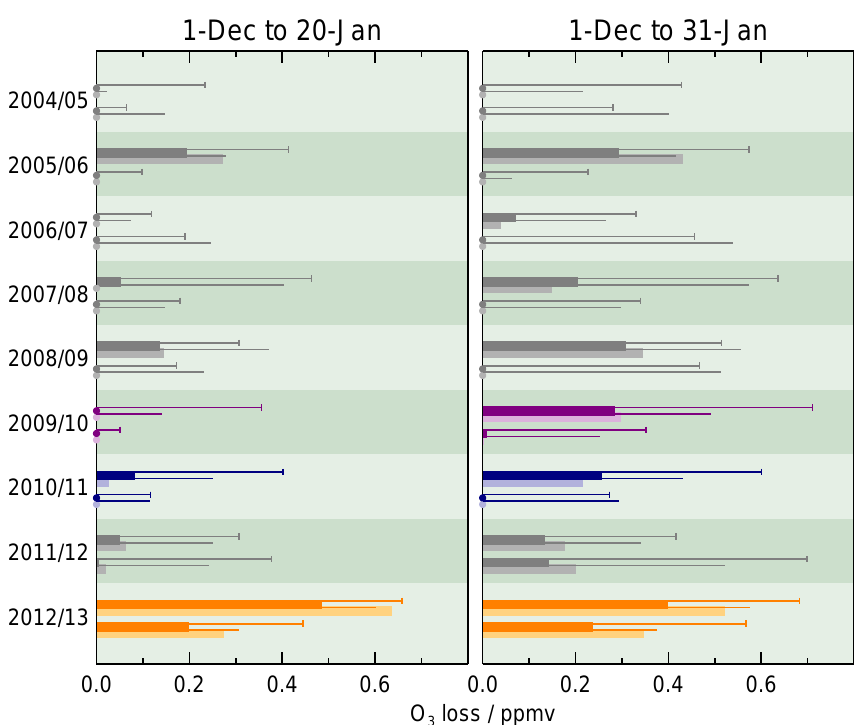
Figure 14. Chemical ozone loss estimates for 1 December through (left) 20 January and (right) 31 January from MLS Match (Livesey et al., 2015) for the 2004/05 through 2012/13 Arctic winters. Integrated ozone loss for each Arctic early winter, in 25K potential temperature bins centered at 500K (top bar of pair for each year) and 450K (bottom bar of each pair), is shown as wide bars, with overlapping wide pale bars showing the calculations using “stricter” match requirements (see Sect. 2.3.3). Dots on the left-hand axis indicate where the estimated ozone change was 0 or positive, indicating no chemical loss. Thin lines extending to the right of the wide bars show uncertainties in ozone calculated assuming N 2 O changes are ascribed to errors in descent (upper lines, with “tails” at right hand end) or mixing across the vortex edge (lower lines, with no tails). As in previous figures, 2009/10, 2010/11, and 2012/13 are highlighted in purple, blue, and orange,